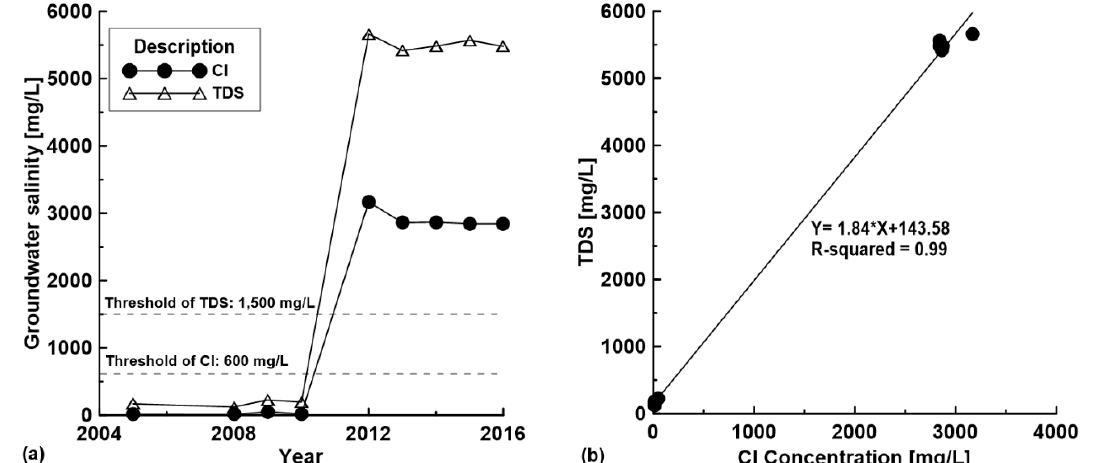
Figure 1. Geochemistry data analyses on investigating seawater intrusion in Kamala: ( a ) historical trend of chlorides (Cl) and total dissolved solids (TDS) and ( b ) cross-plot between Cl and TDS (modified from Puttiwongrak et al. [6]).